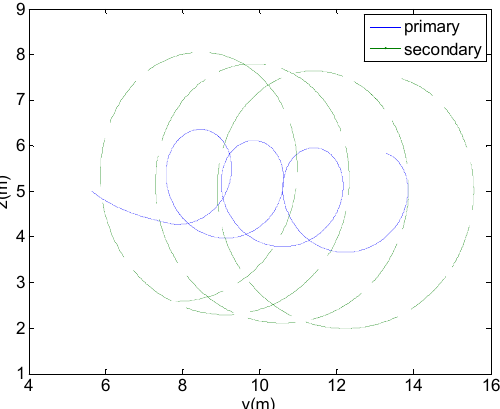
IGE model proposed in this paper.